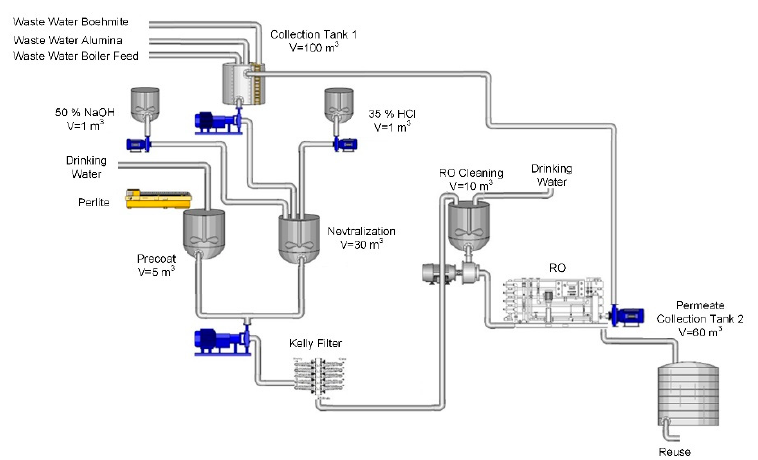
Figure 7. Schematic process scheme for wastewater treatment.